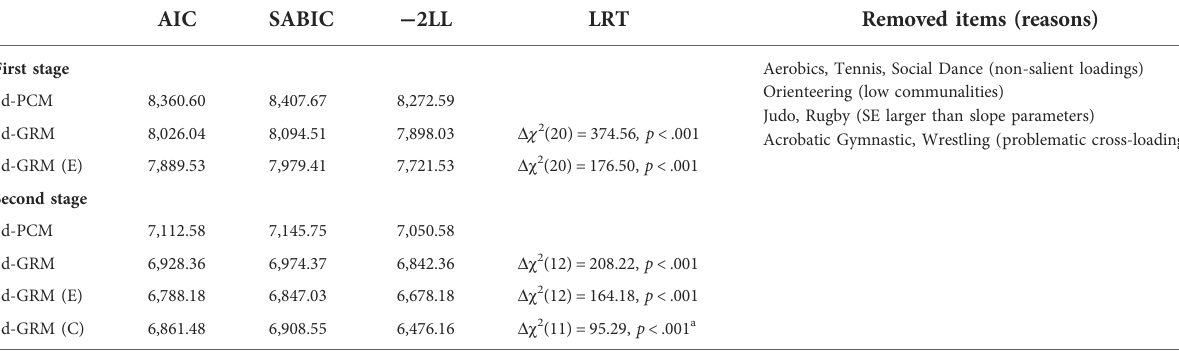
TABLE 6 Model fi t indices and statistics for the movement competence, rules, and tactics